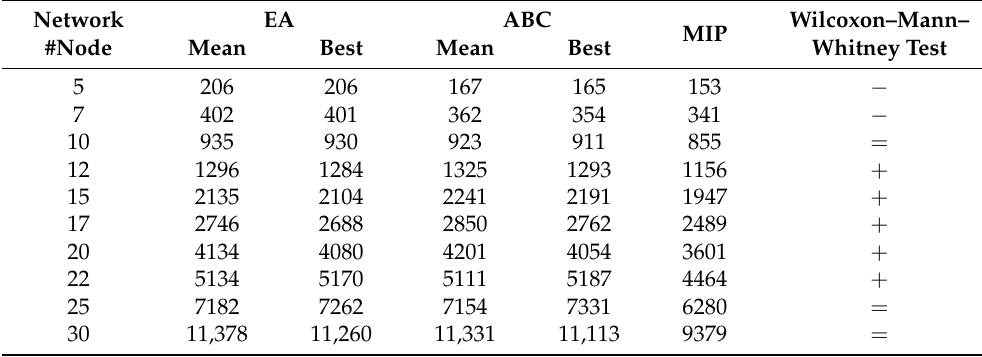
Figure 2. Convergence curves plotted for the algorithms considered, for a logistic network of different sizes, for the ELP model. Each curve is an average of 20 independent runs. ( a ) 5-node. ( b ) 10-node. ( c ) 15-node. ( d ) 20-node. ( e ) 25-node. ( f ) 30-node. Table 1. Comparison of the average and the best value of the objective function evaluation for each test case together with the outcomes of the paired Wilcoxon test, for the BLP model. Symbols + , − and = , in the last column, indicate whether the EA algorithm was better ( + ), worse ( − ) or equal ( = ) to the ABC